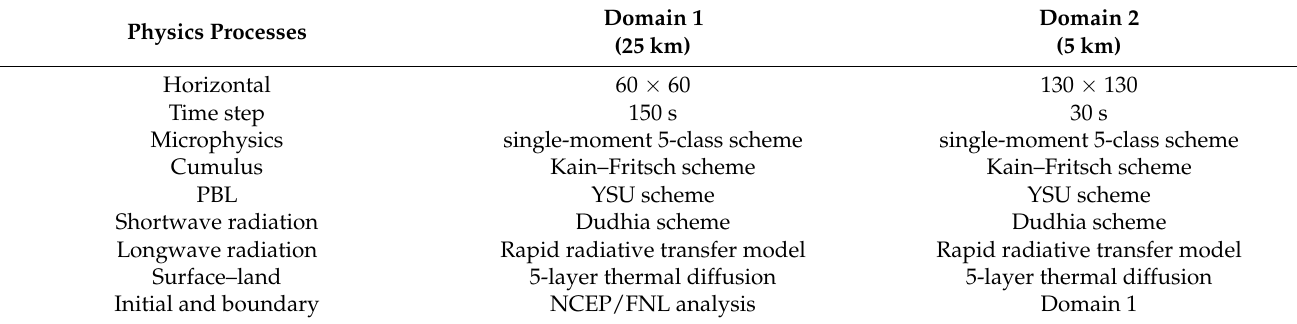
Table 1. Physical configuration of the WRF model used in this